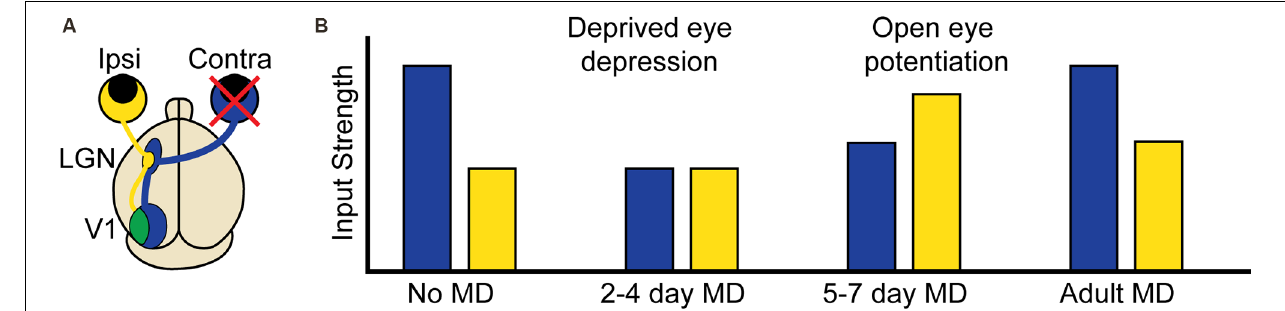
FIGURE 1 | Ocular dominance plasticity in the mouse binocular visual cortex. (A) Visual information from the contralateral (contra, blue) eye first arrives in the contralateral lateral geniculate nucleus (LGN) of the thalamus. Visual information corresponding to the binocular portion of the visual field also arrives from the ipsilateral (ipsi, yellow) eye, but remains largely segregated. This information is then relayed to the visual cortex (V1), where contralateral and ipsilateral visual input corresponding to the binocular portion of the visual field converge in the binocular region. (B) At baseline, the contralateral eye input to binocular V1 is approximately twice as strong as the ipsilateral input. In critical period aged mice, 2–4 days of contralateral monocular deprivation (MD, red X) results in the depression of deprived eye (contralateral) input. At 5–7 days post MD, there is a potentiation of open eye (ipsilateral) input. In adult mice following MD, contralateral depression does not occur but there is still open eye